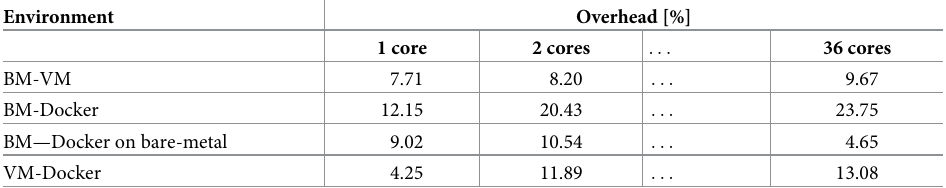
Table 5. Example of the summed up and averaged percentage values for the short dataset of the used envrion- ments (bare-metal (BM), virtual machine (VM), Docker, Docker on bare-metal).